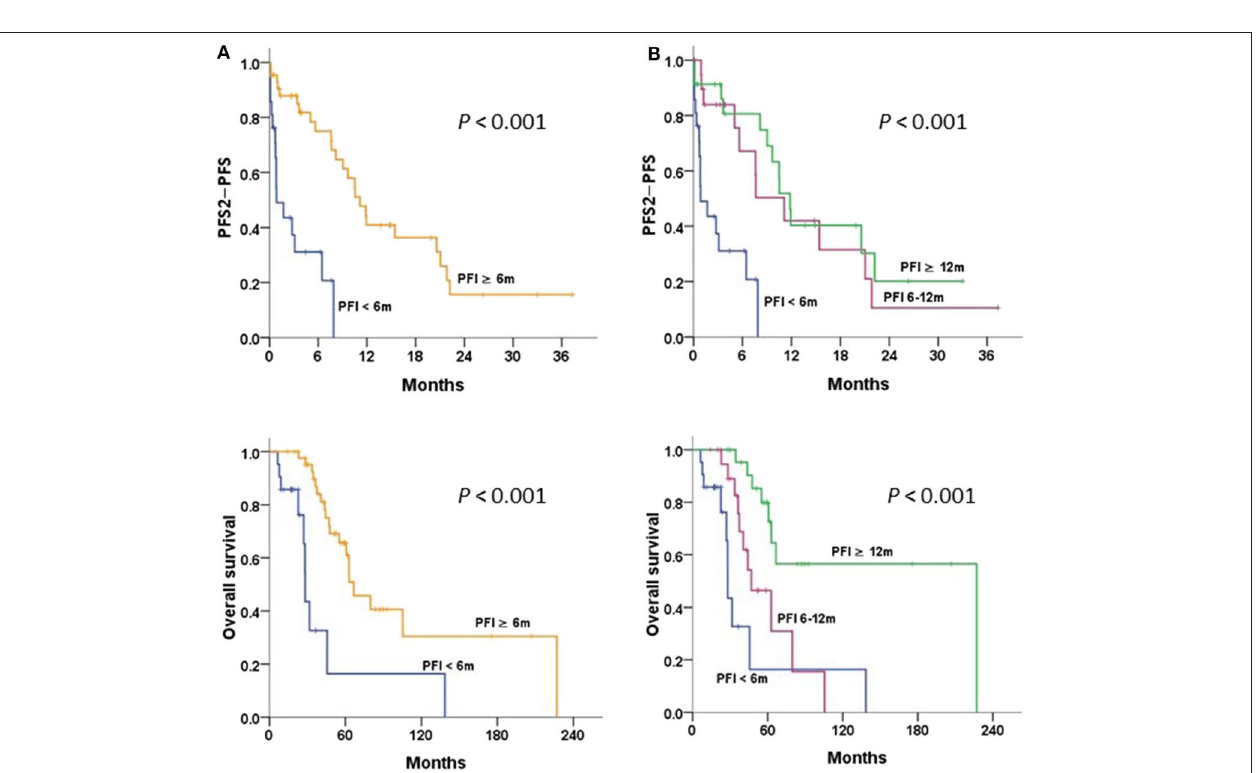
FIGURE 4 | Progression-free survival 2 (PFS2)-PFS and overall survival in patients with relapsed/persistent disease treated with bevacizumab (BEV) ± chemotherapy (Chemo), stratified by (A) progression-free interval (PFI) < and ≥ 6m; (B) PFI < 6, 6–12, and ≥ 12m, tested by the log-rank test.